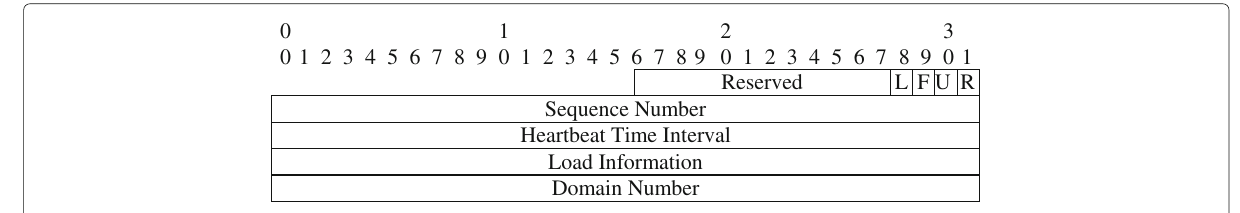
Fig. 7 Heartbeat message, including the domain